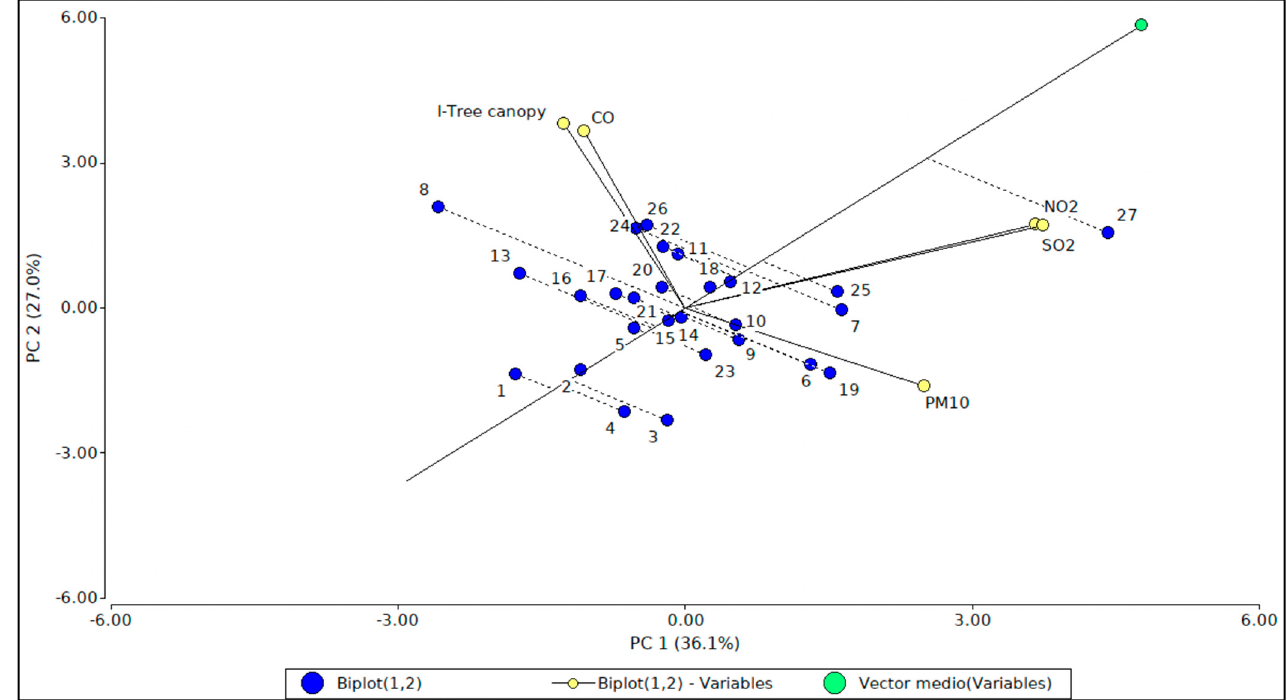
Figure 5. Principal component analysis correlation between pollutants and vegetation cover. For sample points location see Figure 1.